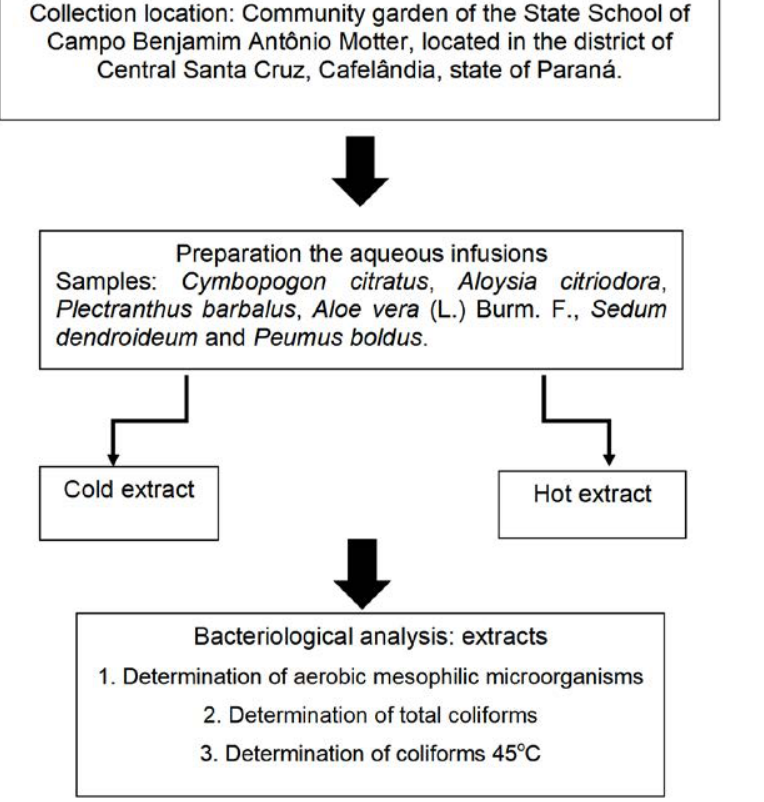
Fig. 1. Scheme of the processing stages of medicinal